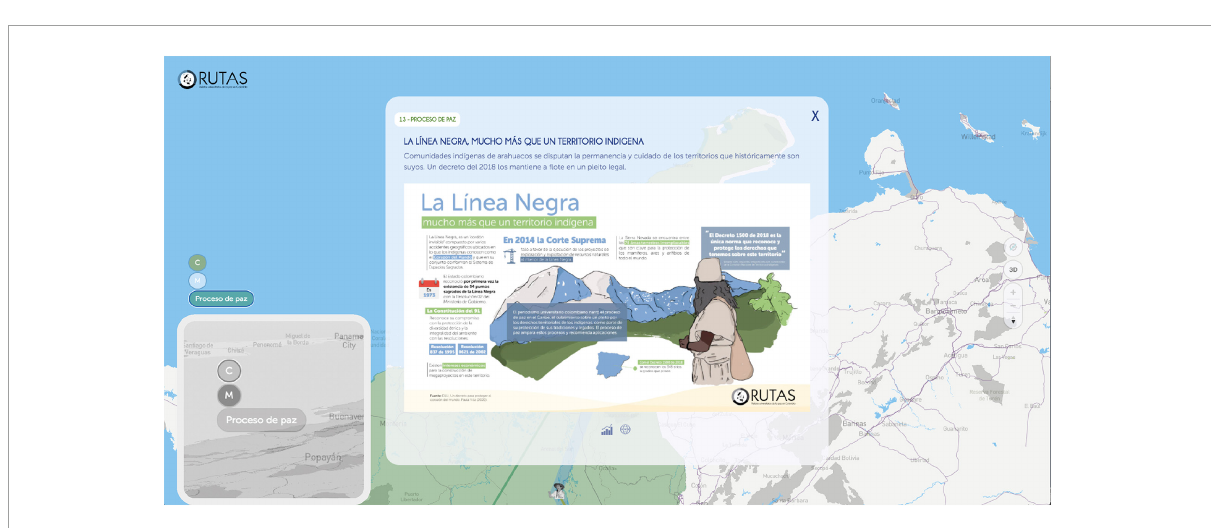
FIGURE4 Navigation view of the cluster Peace Process on the platform. Infographic “La Linea Negra” (Black Line). Source: RUTAS